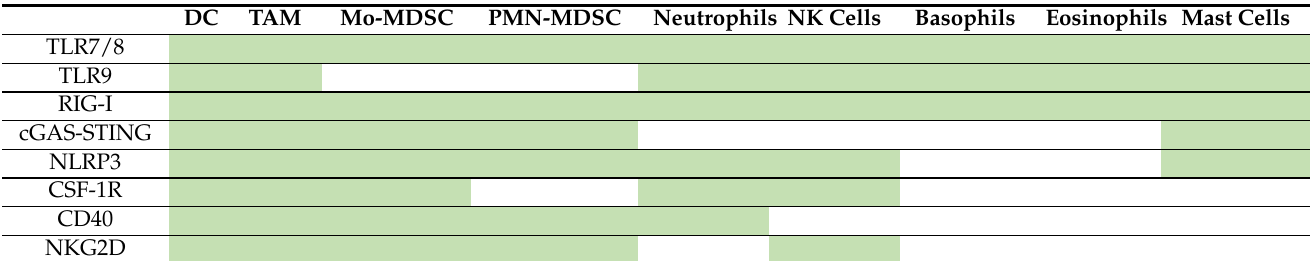
Table 1. Innate immune cell expression of PRRs and PAMP/DAMP-sensing